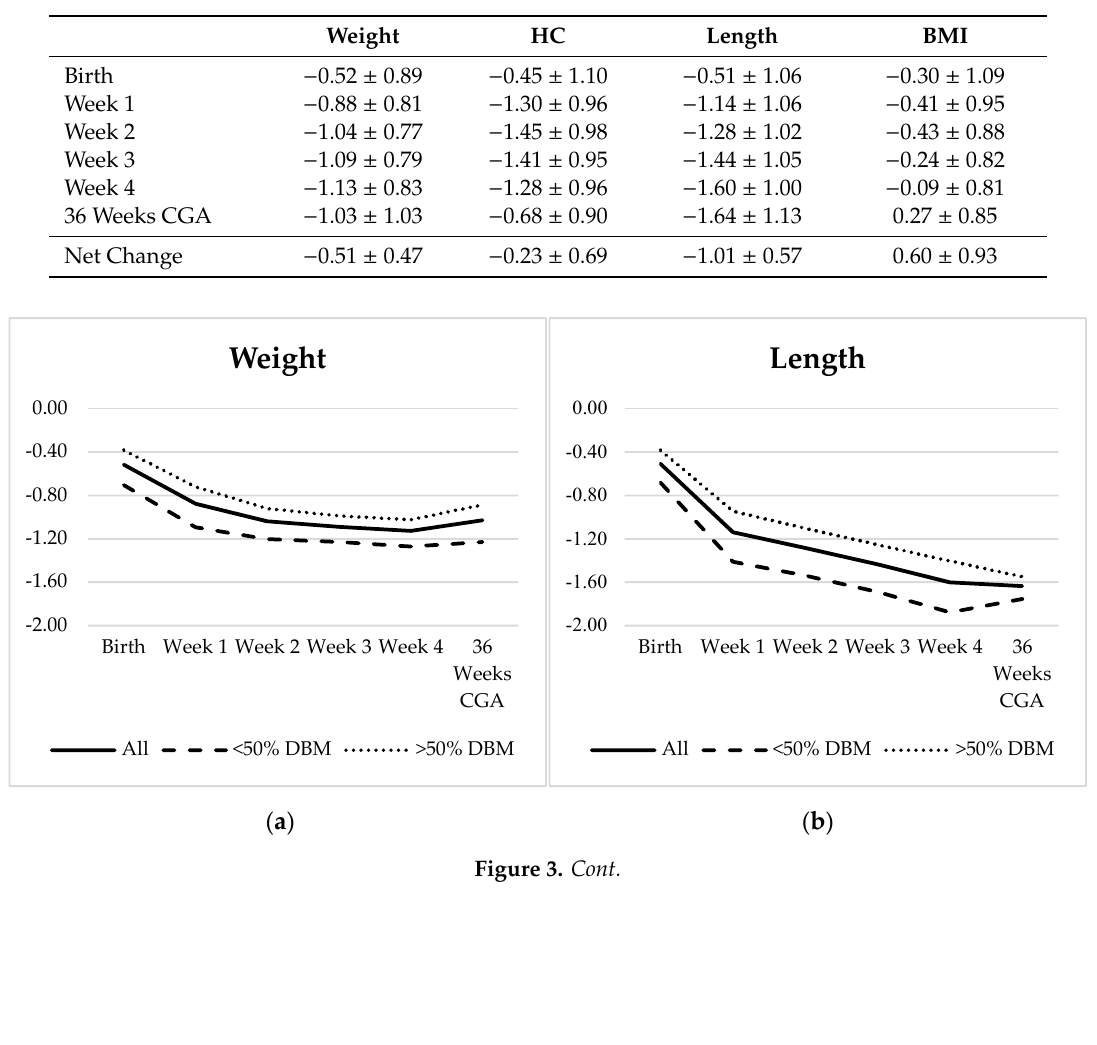
Table 5. z-scores of anthropometric measurements each week and at 36 weeks corrected gestational age (CGA). Mean ± SD.